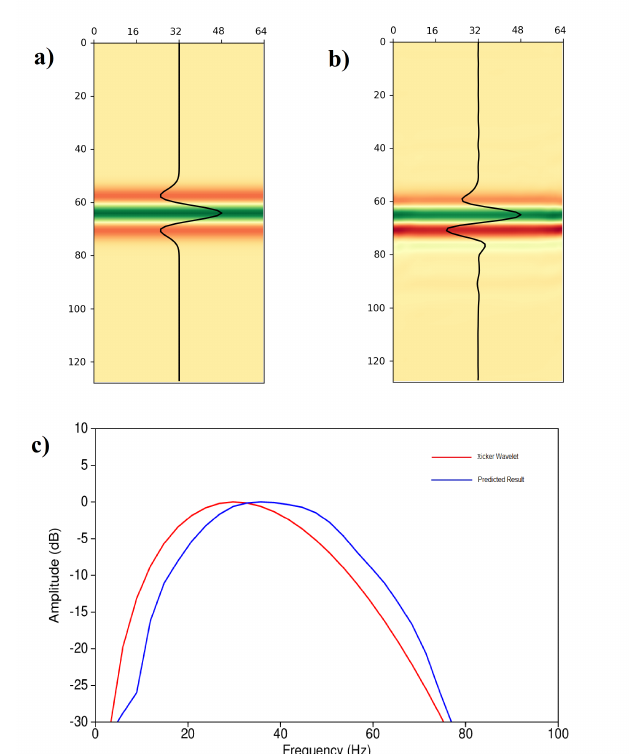
Figure 10. Panel ( a ) shows the ricker wavelet, whereas panel ( b ) shows the corresponding predicted result using the trained convolutional neural network (CNN). The black lines in panel ( a , b ) represent the respective waveforms. The red line and blue line in panel ( c ) represent the spectrums of the ricker wavelet and its predicted result, respectively. The trained model can improve the dominated frequency of the ricker wavelet from 30 Hz to approximately 40 Hz. In addition, the phase is corrected, as